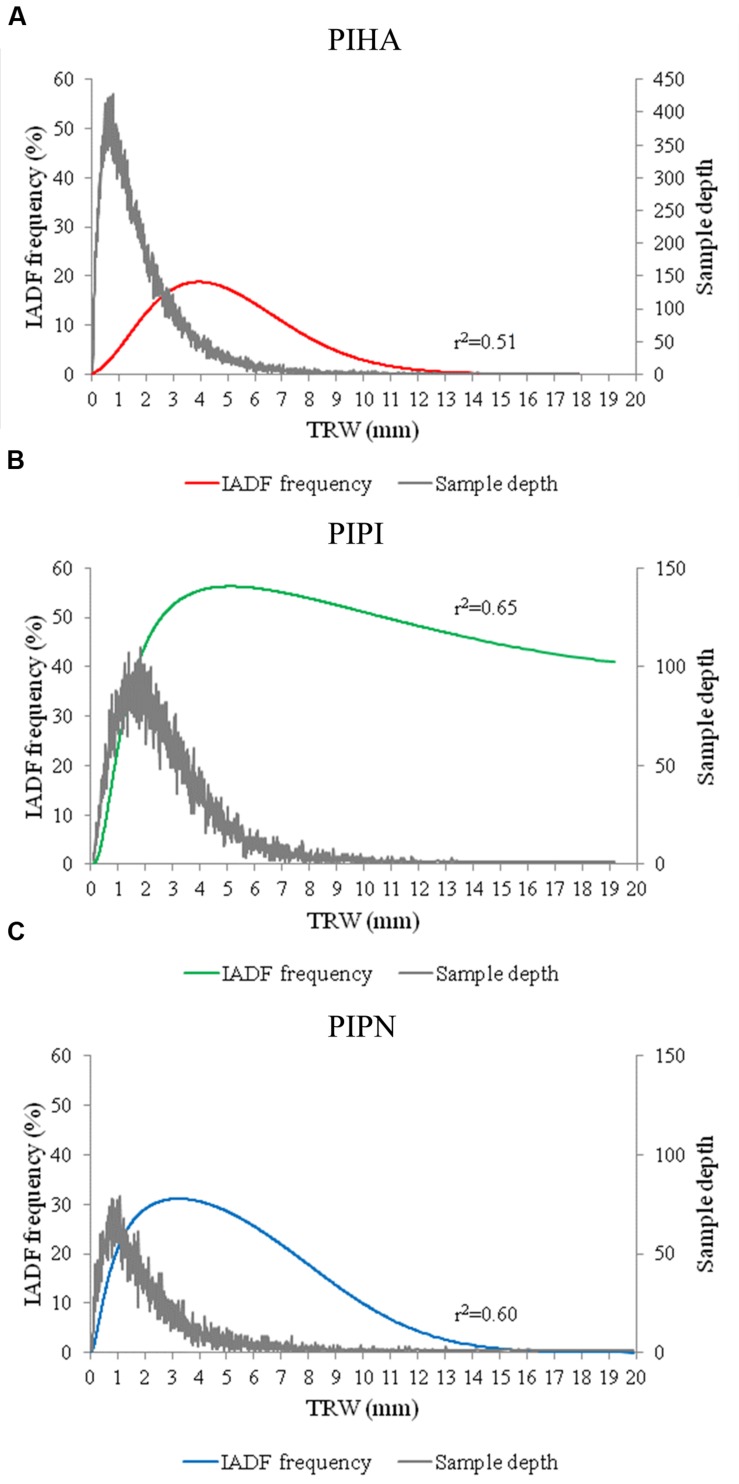
Logistic binomial regressions between IADF frequency and tree-ring width for the three species (PIHA, Pinus halepensis; PIPI, Pinus pinaster; PIPN, Pinus pinea). IADF frequency and number of samples related to tree ring width for (A)
Pinus halepensis (PIHA), (B)
Pinus pinaster (PIPI), and (C)
Pinus pinea (PIPN). TRW refers to tree-rings aligned from the narrowest to the widest ones.